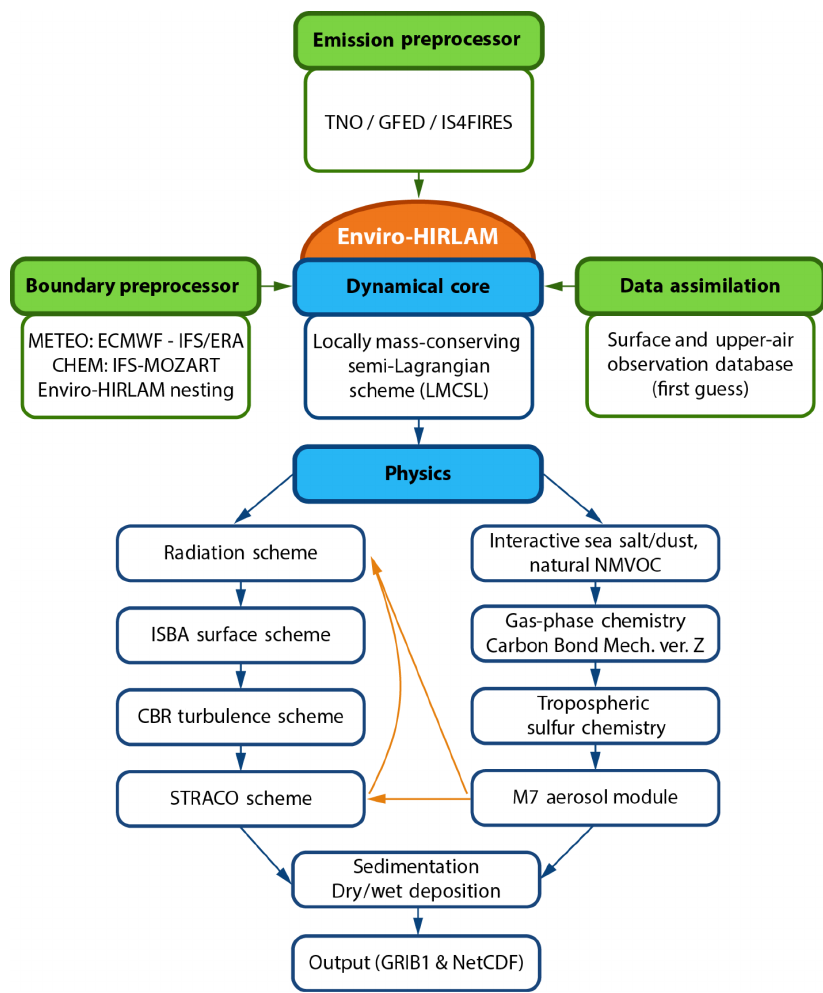
Figure 2. Schematics of the Enviro-HIRLAM modelling system.